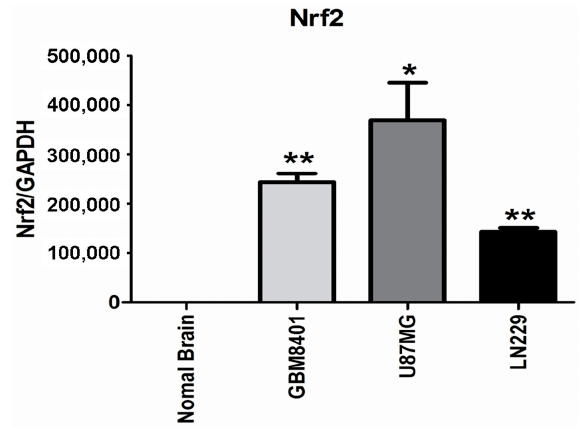
Figure 2. qRT-PCR was performed to examine Nrf2 mRNA expression in U87MG, LN229, GBM8401 and U118MG human glioma cell lines and normal brain tissue. The relative expressions were normalized with normal brain tissue. Bars, means ˘ SEM; * means p < 0.001, ** means p < 0.01. Data are representative of three independent experiments.